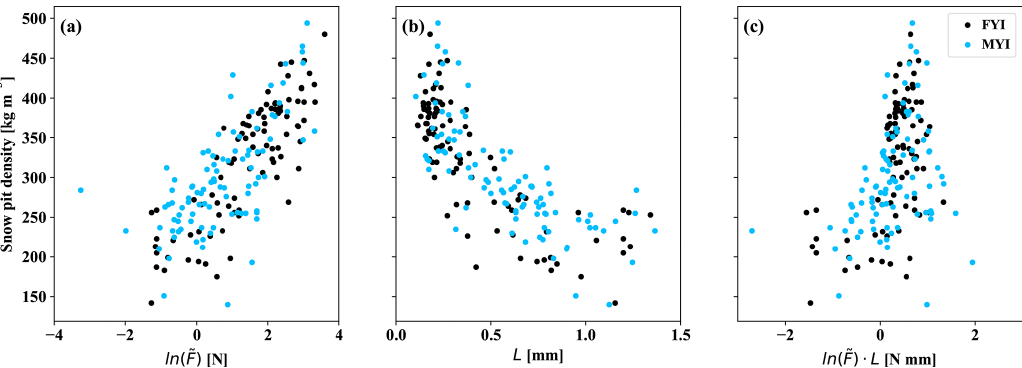
Figure 5. Comparison of the SMP regression parameters and corresponding snow pit observed density. Parameters include log-transformed median force (ln ( ˜ F ), (a) , microstructure length scale ( L , b ), and an interaction term ( ˜ f L , (c) . Relationships are separated by ice type (FYI and MYI).